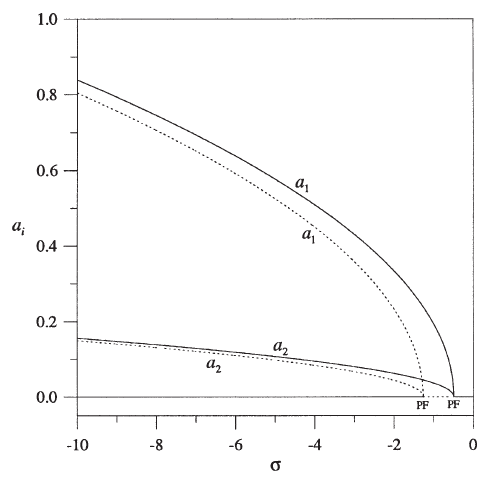
Fig. 8. Amplitude-response curves for an additive-type external sub- combination resonance involving modes 1 and 3 for (cid:27) = (cid:0) 1, (cid:22) 1 = 0 : 0137 and (cid:22) 3 = 0 : 076. Solid lines (—) denote stable fixed points and dashed lines (– – –) denote unstable fixed points.